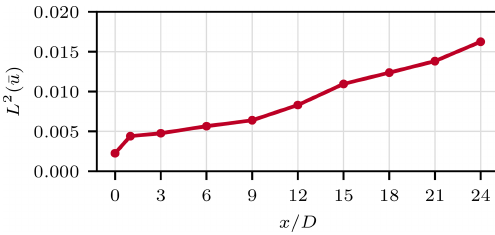
Figure 15. Relative difference ( L 2 -relative error norm) between the NS and CLBM solution in u in turbulent inflow along velocity profiles as given in Fig.